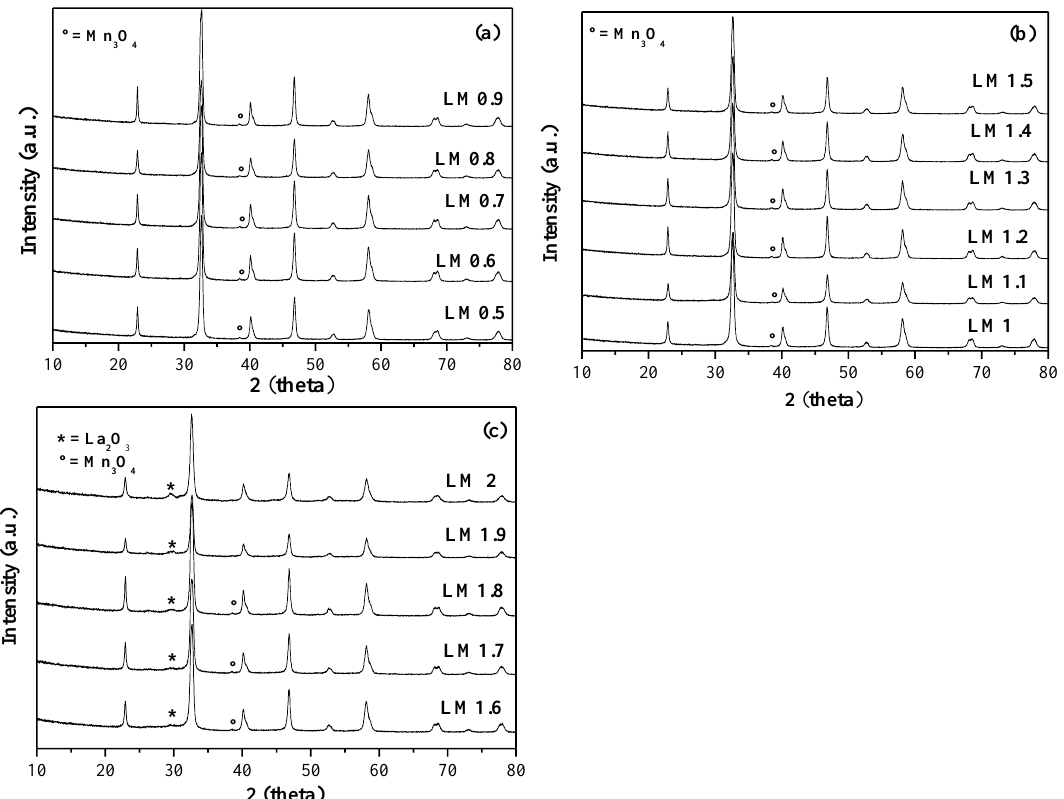
Figure 1. X-ray diffraction (XRD) patterns of LaMnO 3 samples prepared with low molar ratio of CA to total metal ions (La 3+ + Mn 2+ ) ( a ), medium molar ratio ( b ), and high molar ratio ( c ).